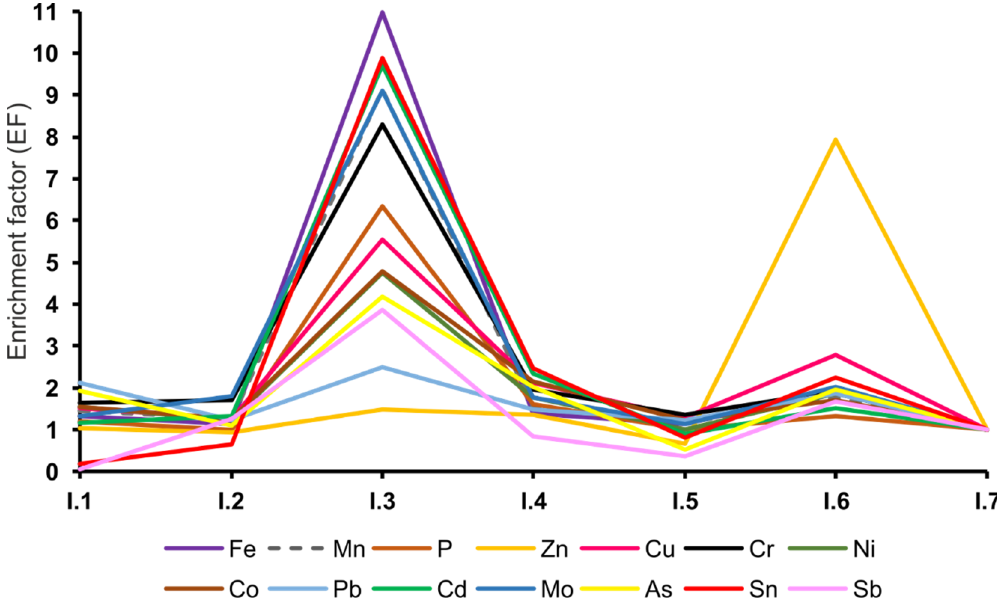
Figure 10. Enrichments factors (EFs) for metals in dusts collected in the mine interior with respect to local geochemical background concentrations from site I.7 (elements with low EFs values are not shown).